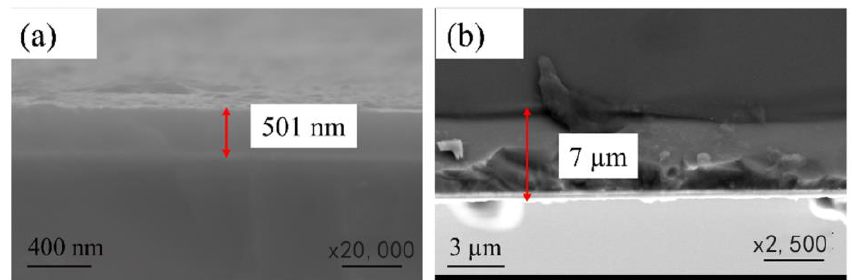
Figure 3. Cross-sectional morphologies of ( a ) TD and ( b ) TTTD films.